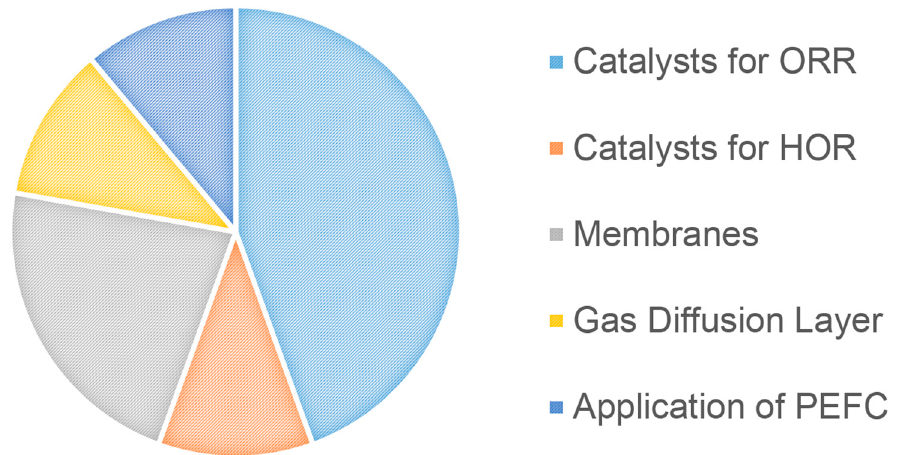
Figure 1. Distribution of the contributions of this Special Issue by topics.